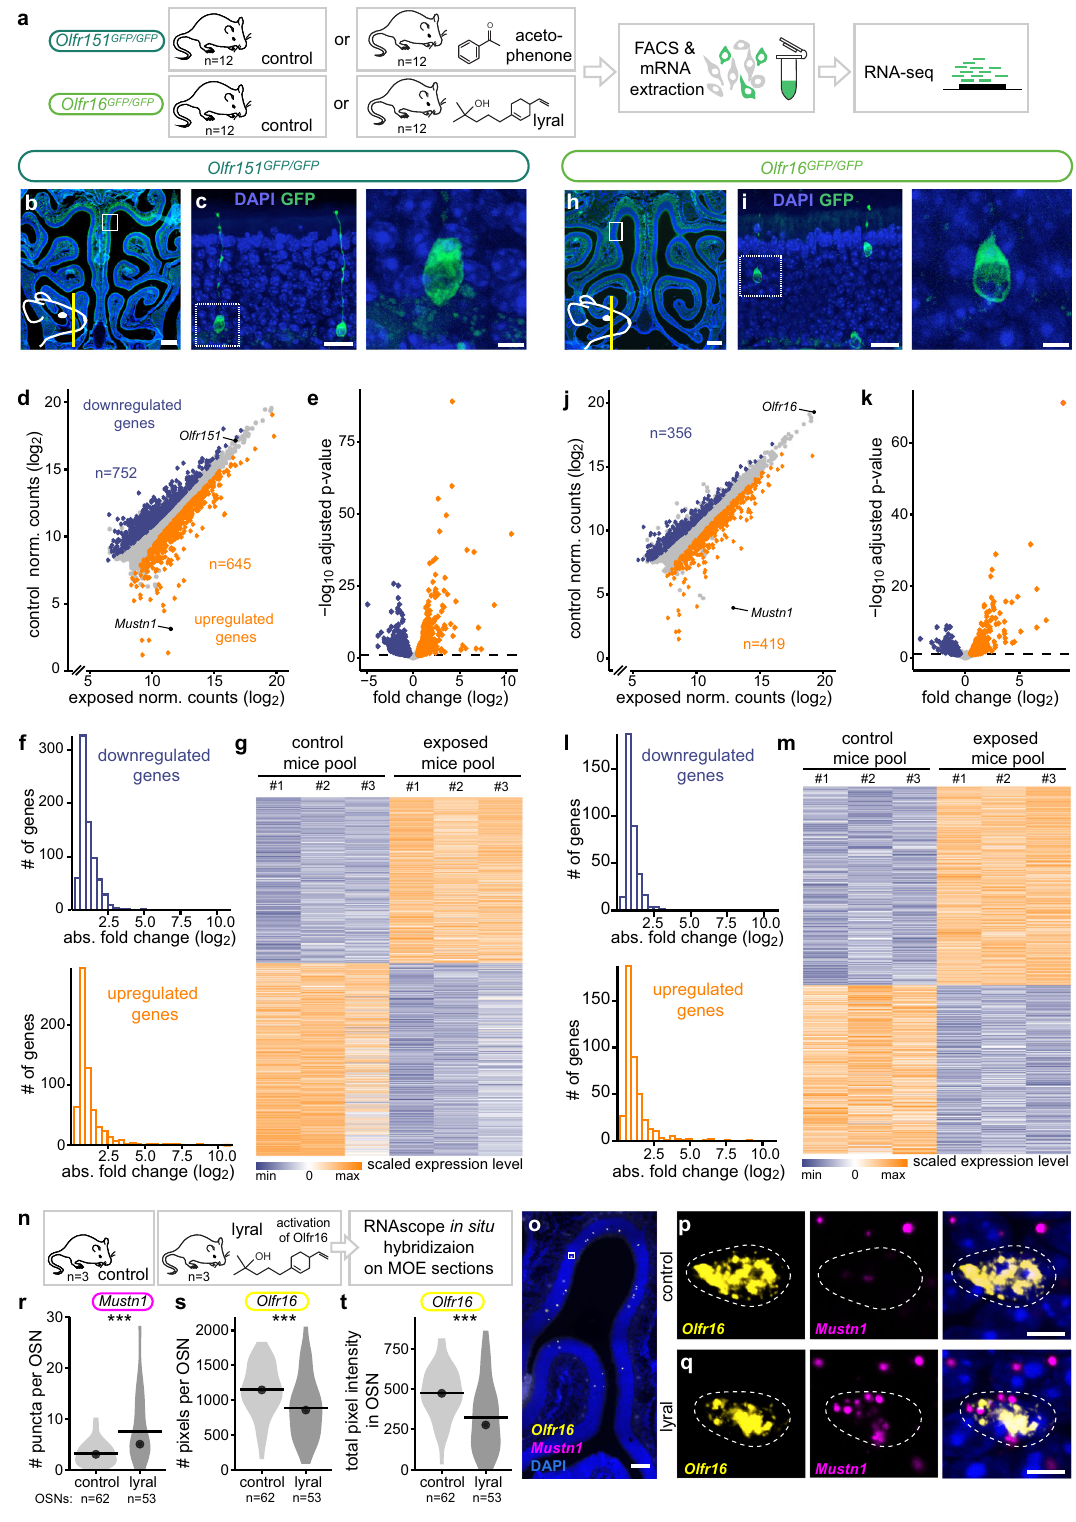
signi fi cantly enriched terms, we found “ signaling ” and “ G- protein-coupled receptor activity ” in the GO biological processes terms, “ molecular transducer activity ” in the GO molecular functions category, and “ plasma membrane ” and “ cell periphery ” in the GO cellular components category (Fig. 4j and Supplemen- tary Table 2). A pattern thus emerged, pointing to actors of the transduction cascade being modulated by agonist exposure.